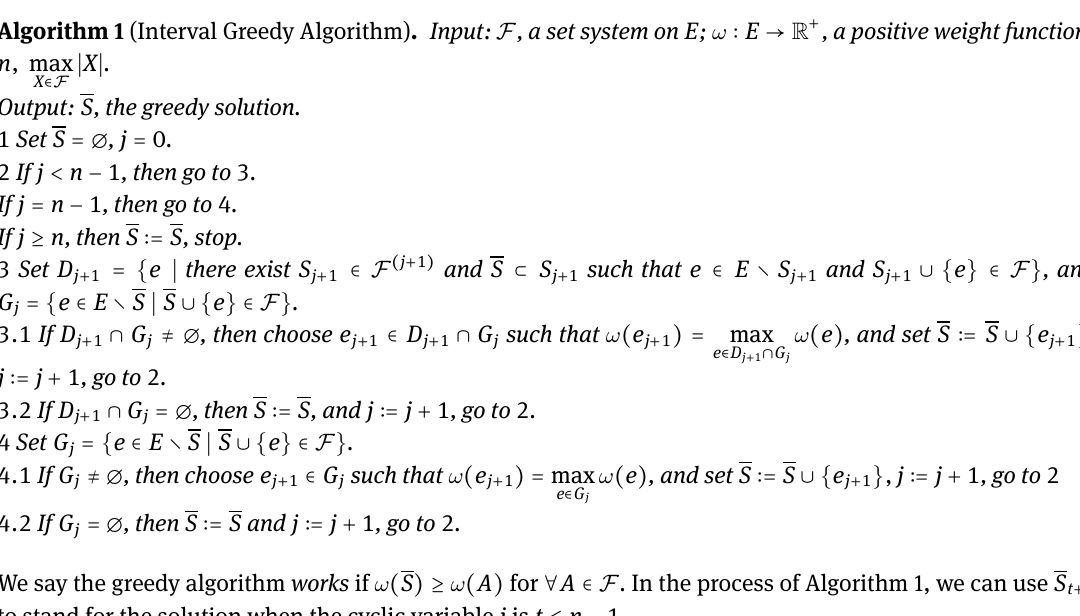
Algorithm 1 (Interval Greedy Algorithm) . Input: F , a set system on E; ω ∶ E → R + , a positive weight function; n , max ∣ X ∣ X ∈F